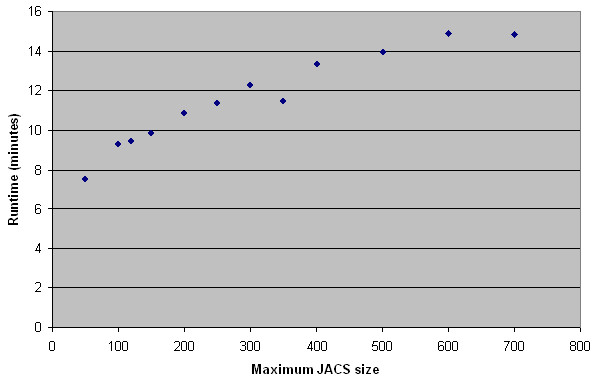
Dependence of the running time on the size of the JACS. The running time of MATISSE with different maximum JACS size parameters. The execution did not include the weight calculation step, as it is not dependent on the JACS size.